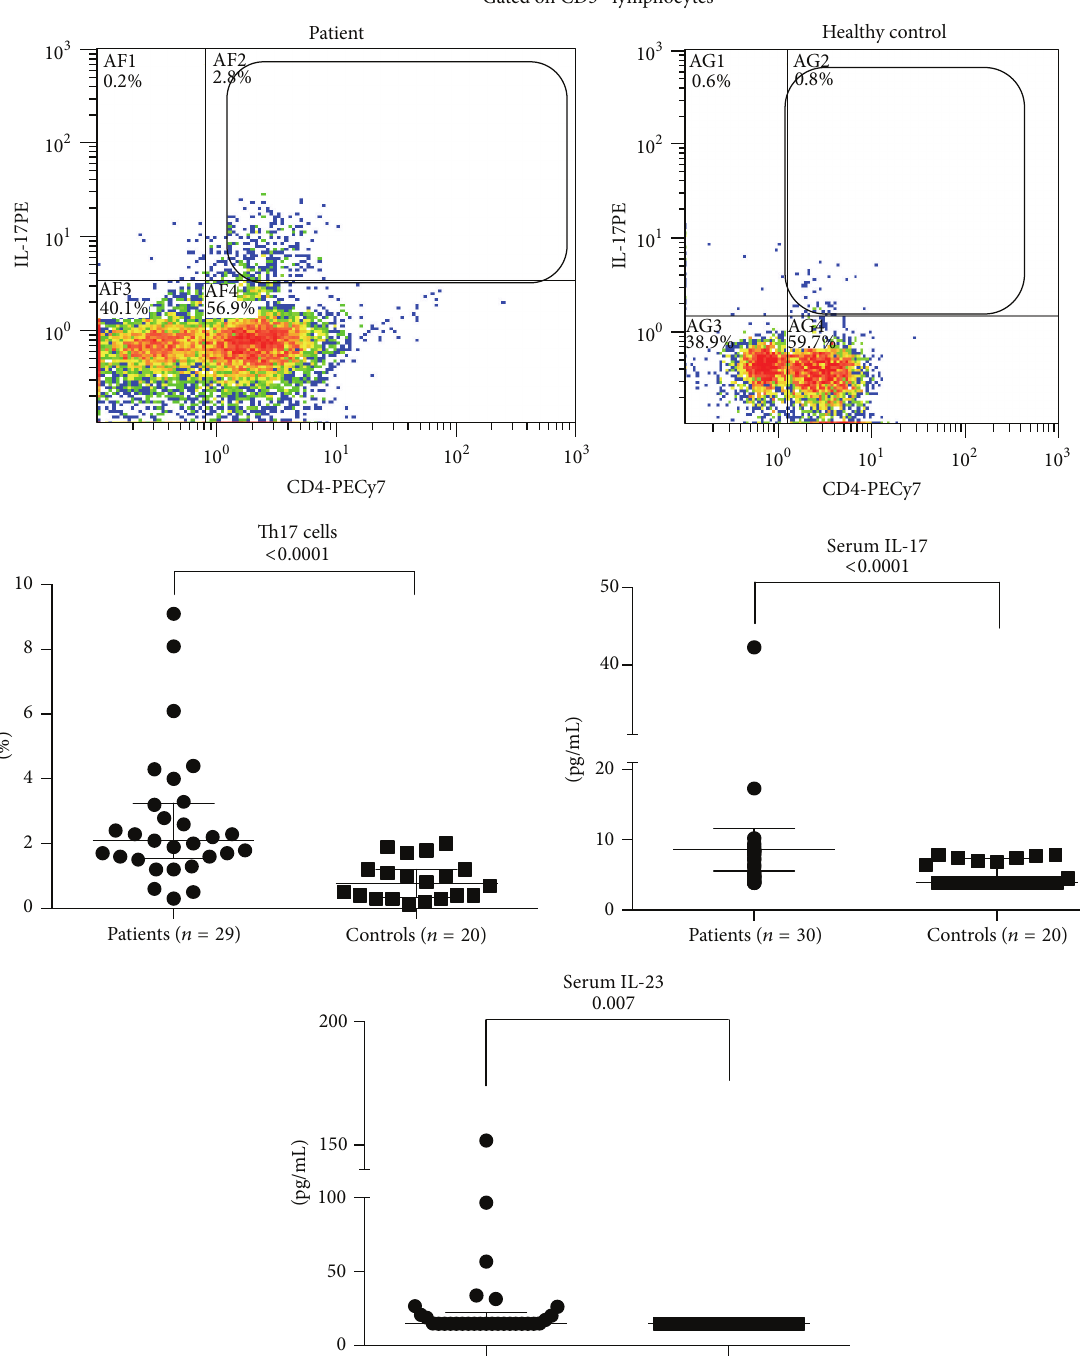
Figure 3: T-helper 17 (Th17) cells were measured in peripheral blood of 29 patients (could not be studied in one patient due to technical difficulties) and 20 healthy controls, after culture of whole blood for 6 hours followed by gating on CD3 + lymphocytes. Th17 cells were identified by surface staining for CD4 and intracellular staining for IL-17A. Serum IL-17A and IL-23 were measured by ELISA. Bars represent median with interquartile range. 𝑝 value (Mann-Whitney test) is mentioned in each